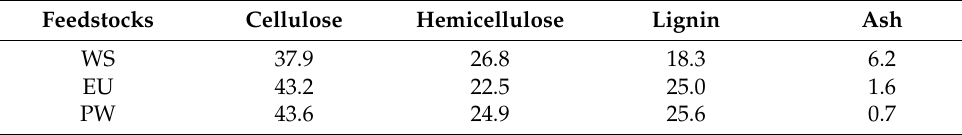
Table 1. Chemical composition of the feedstocks, adapted from Jensen et al. [27].